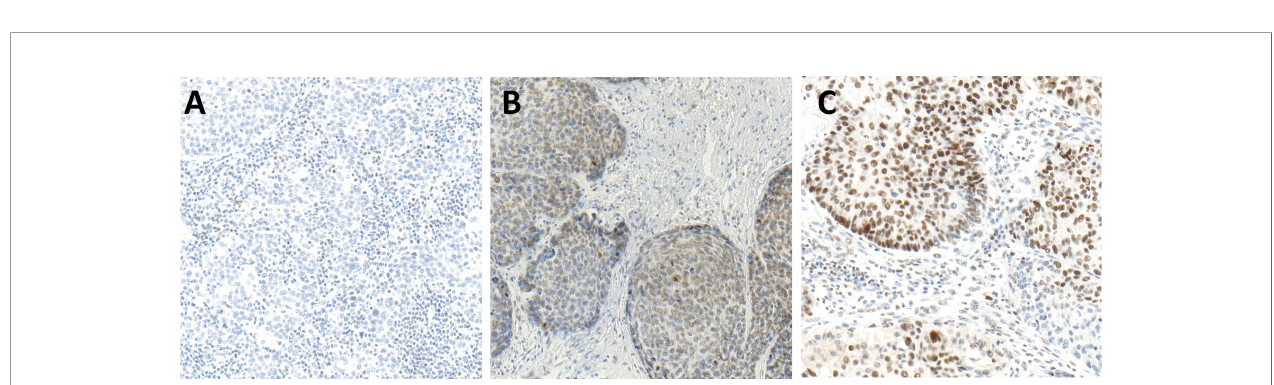
FIGURE 3 | Immunohistochemistry (IHC) of pSMAD expression in hot (A) , cold (B) , and excluded (C) head and neck squamous cell carcinomas (HNSCCs). Hot HNSCCs (A) showed very low pSMAD expression, while excluded HNSCCs (C) had very high pSMAD expression. In cold HNSCC (B) , the pSMAD expression was in